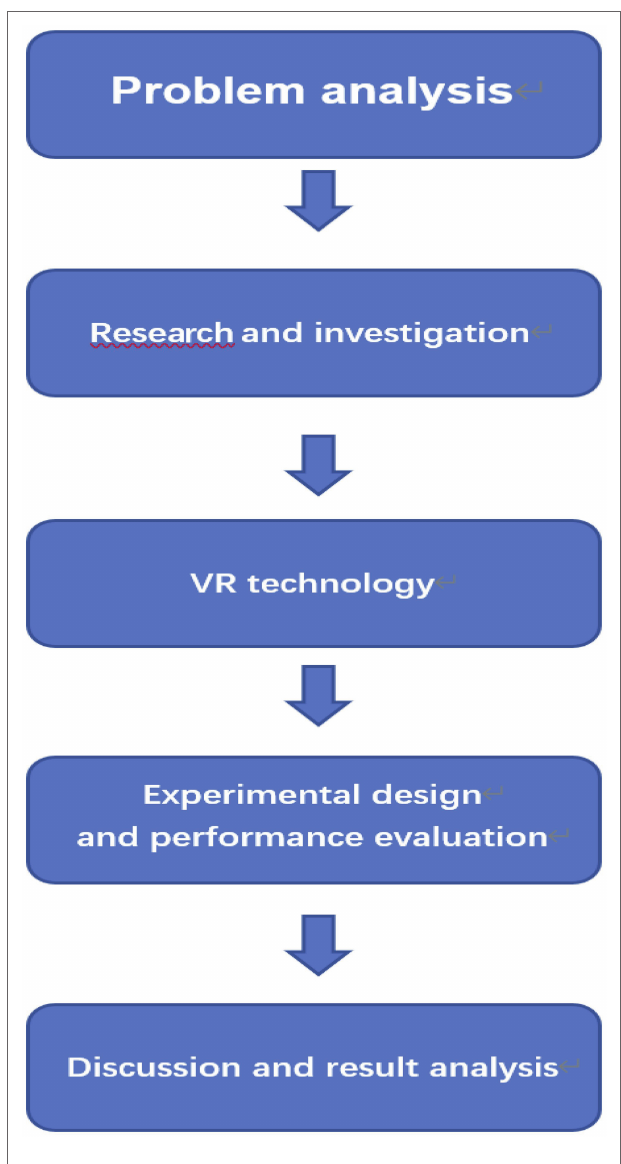
FIGURE 2 | The research process of proposed